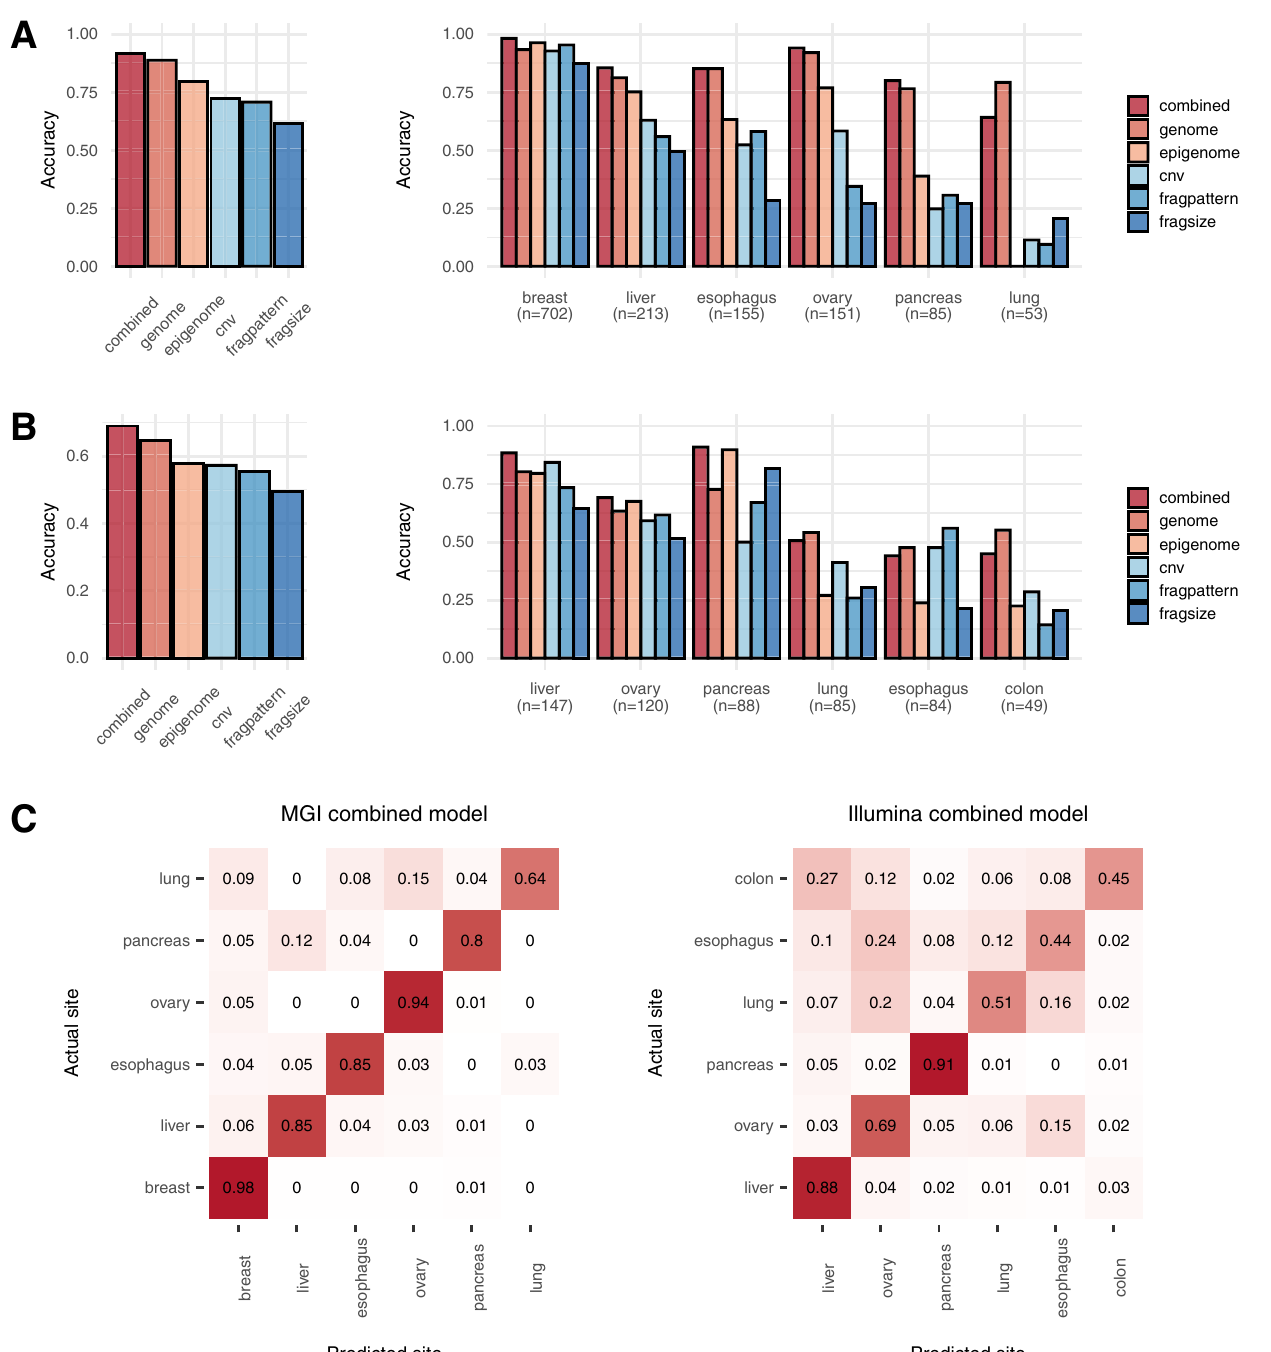
Fig.3|Performanceoftissue-of-originlocalization.A Averageaccuracy(left)and accuracy (right) on each cancer type for different models on the MGI training cohort. B Average accuracy (left) and accuracy (right) on each cancer type for different models on the Illumina training cohort. C Confusion matrix for localiza- tionusingthecombinedmodelontheMGIcohort(left)andIlluminacohort(right). The y-axis represents the actual site, and the x-axis represents the predicted site.